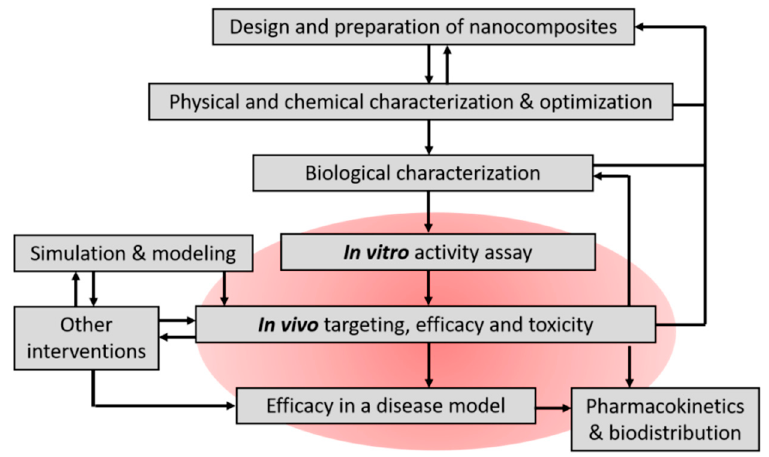
Figure 1. Schematic diagram of proposed steps in development of therapeutic nanocomposites for target thrombolysis. Arrows indicate sequences or feedback consideration in the development. This review focuses on the pharmacological evaluation of the nanocomposites, as included in the red area.